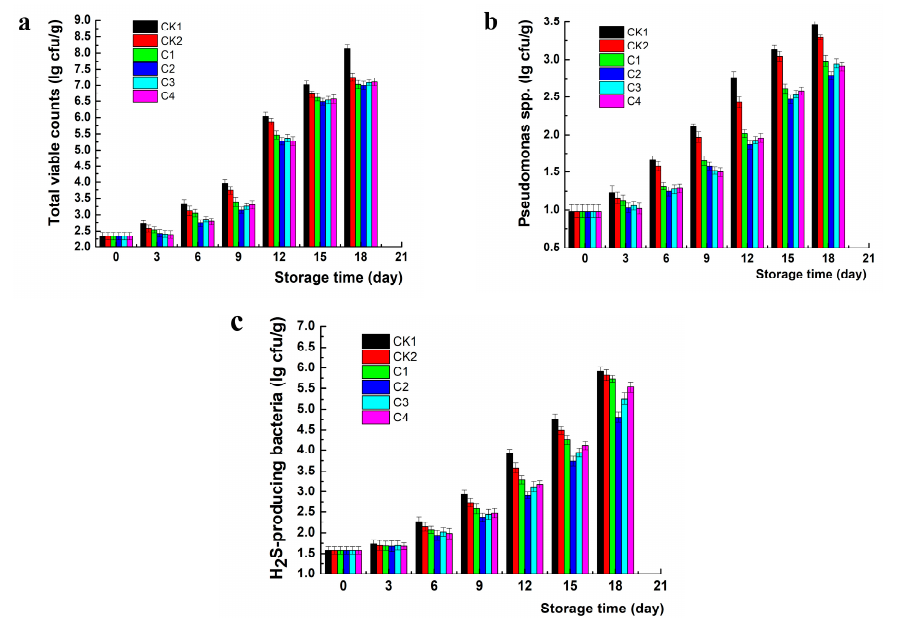
Figure 1. Changes in total viable bacteria ( a ), Pseudomonas spp. ( b ), and H 2 S-producing bacteria ( c ) of half-smooth tongue sole fillets during refrigerated storage (CK1: Chitosan coating without rosmarinic acid or ε -PL; CK2: Chitosan coating with 30 mg / kg rosmarinic acid; C1 / C2 / C3 / C4: chitosan coating with 30 mg / kg rosmarinic acid and 0.05% / 0.10% / 0.15% / 0.20% ε‐ PL).